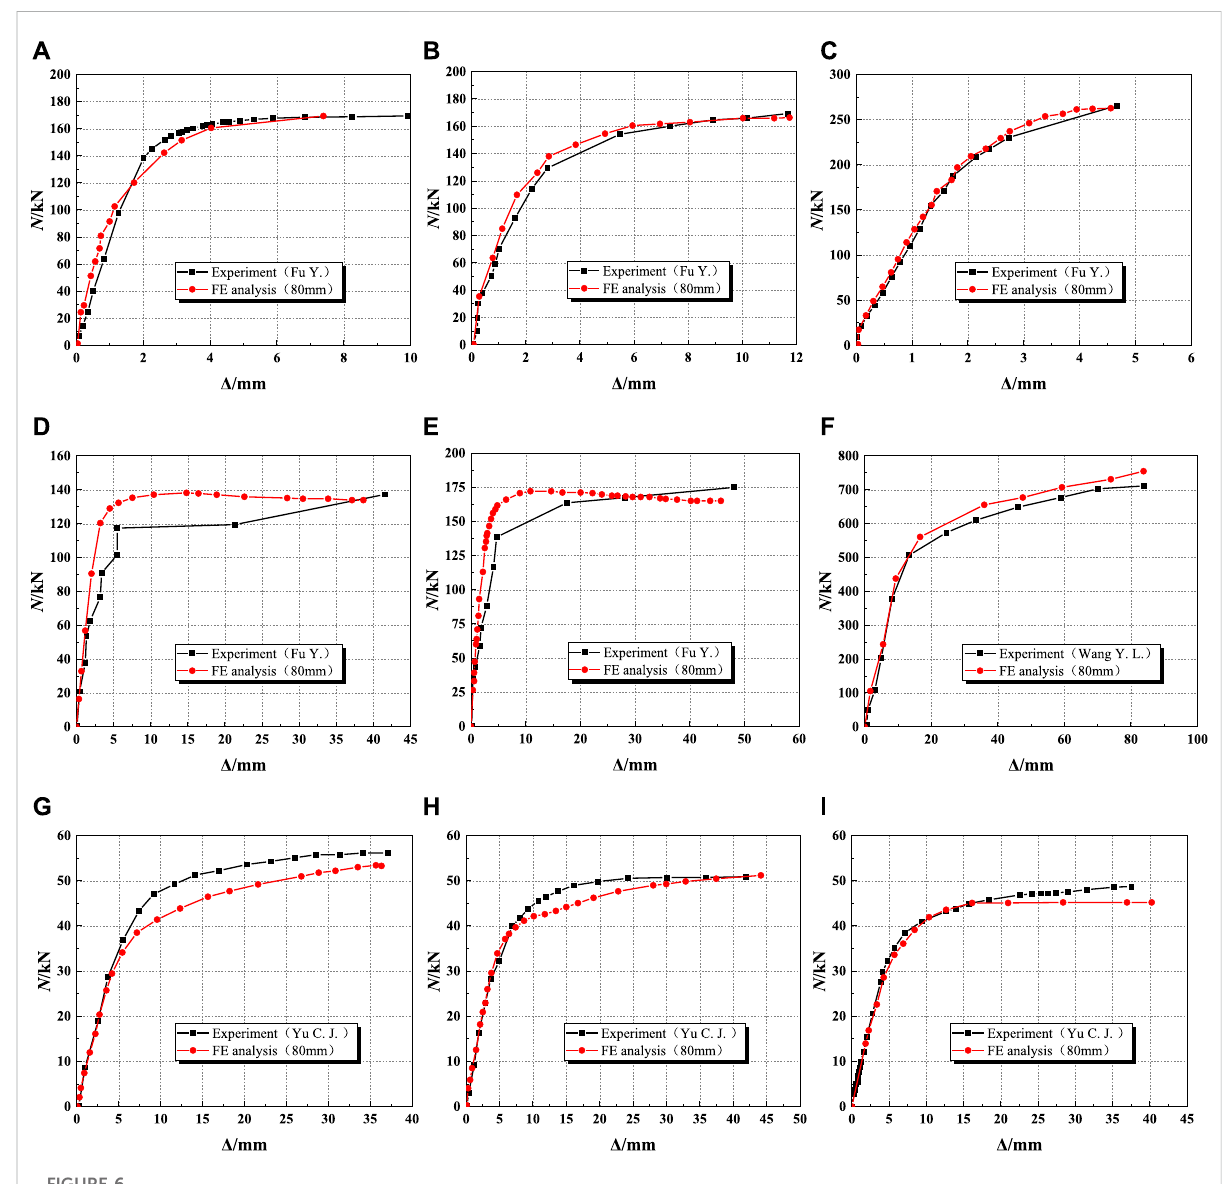
FIGURE 6 Comparisons between simulated curves and experimental curves (A) L1 (B) L2 (C) L3 (D) L4 (E) L5 (F) L6 (G) L7 (H) L8 (I) L9 (J) L10 (K) L11 (L) L12 (M) L13 (N) L14 (O) L15 ( P ) L16 (Q) L17 (R) L18 (S) L19.